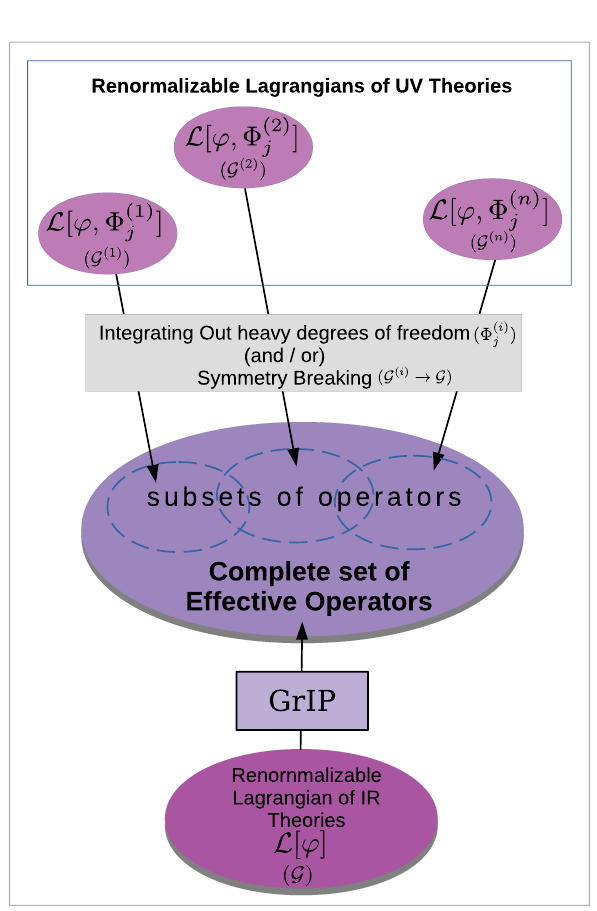
Fig. 10 A schematic depiction of the two approaches to EFT and their interplay. Here, ϕ and G represent the degrees of freedom and gauge ( i ) represent the heavy fields of the i -th group of the IR theory while Φ j UV theory and G ( i ) represents the corresponding gauge groups. GrIP generates a superset of effective operators for a given low energy theory